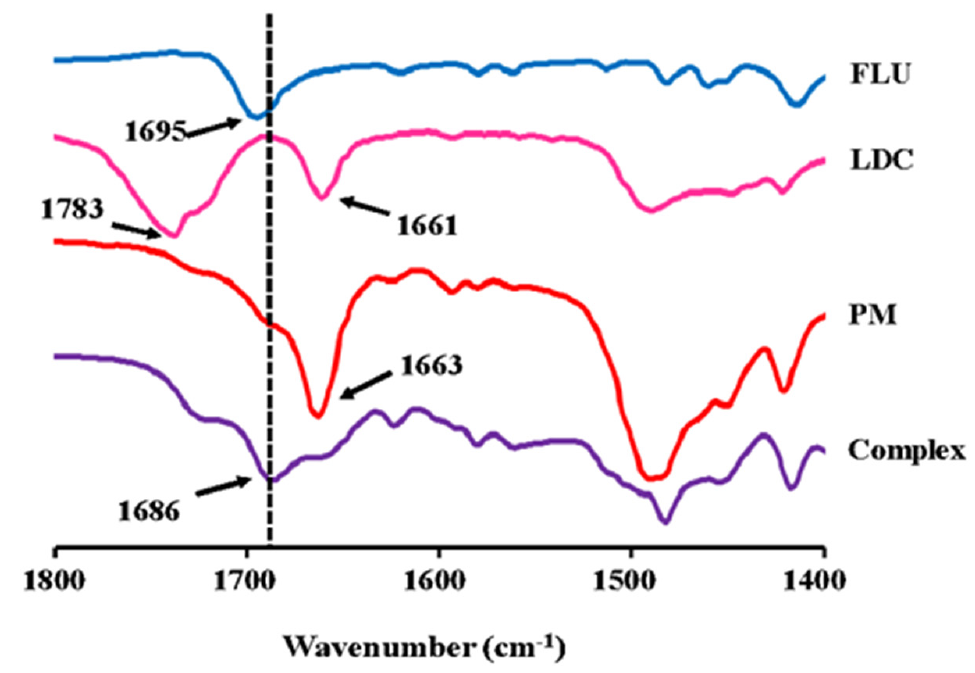
Figure 2. ATR-FTIR spectrum for the FLU, LDC, PM, and FLU/LDC complex.